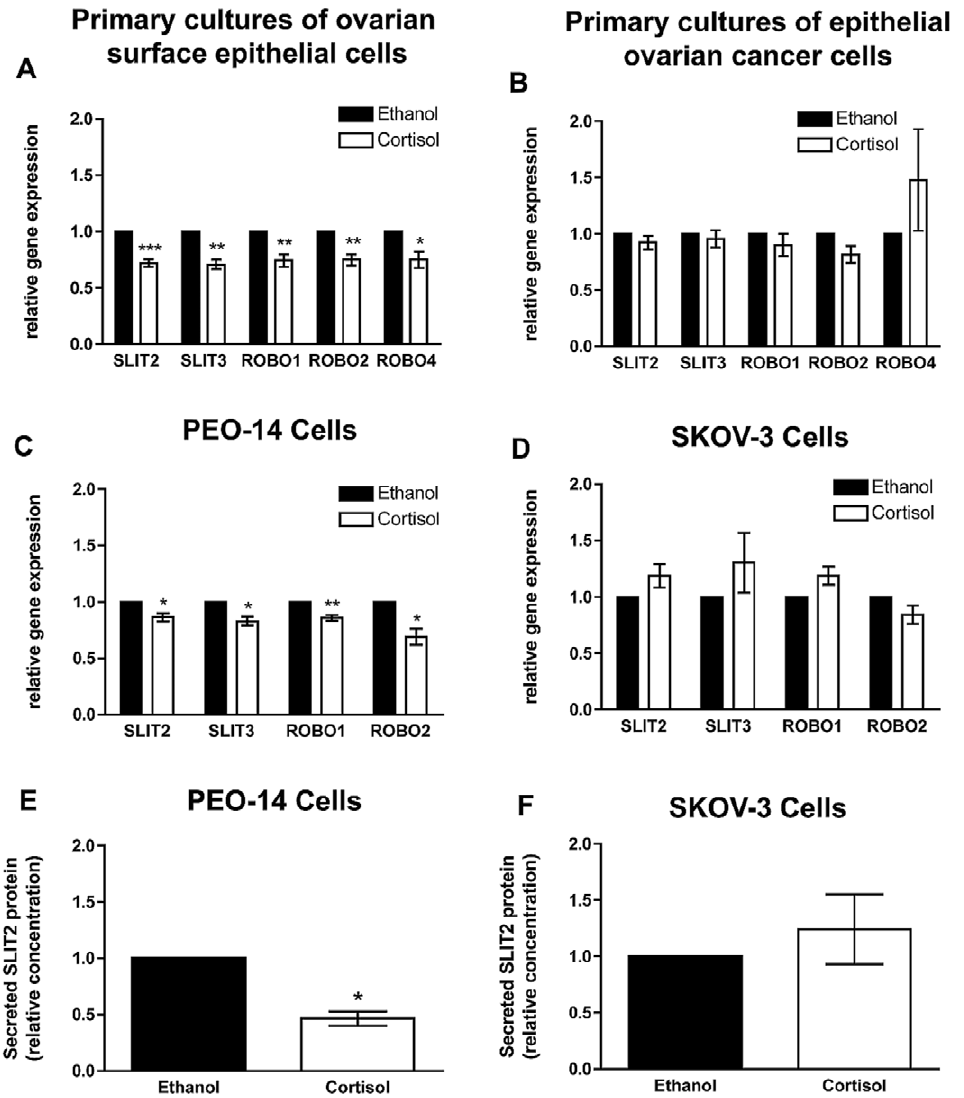
Figure 4. The effect of cortisol on the SLIT/ROBO pathway. A ) Real-time quantitative PCR showing that Cortisol (1000 nM), compared to Ethanol carrier control, reduced SLIT2 , SLIT3 , ROBO1 , ROBO2 and ROBO4 expression in primary cultures of hOSE. B ) Cortisol did not alter the expression of SLITs and ROBOs in primary cultures of ovarian epithelial cancer cells. C ) SLIT2 , SLIT3 , ROBO1 and ROBO2 expression was significantly reduced by Cortisol in more differentiated PEO-14 cells. D ) However expression of these SLITs and ROBOs was not regulated by Cortisol in the poorly differentiated SKOV-3 cells. E ) Cortisol reduced secreted levels of SLIT2 protein in the PEO-14 cells (control secretion is 0.5 ng/ml). F ) Cortisol did not affect secreted levels of SLIT2 protein in the SKOV-3 cells (control secretion is 0.5 ng/ml). *= P , 0.05; **= P ,